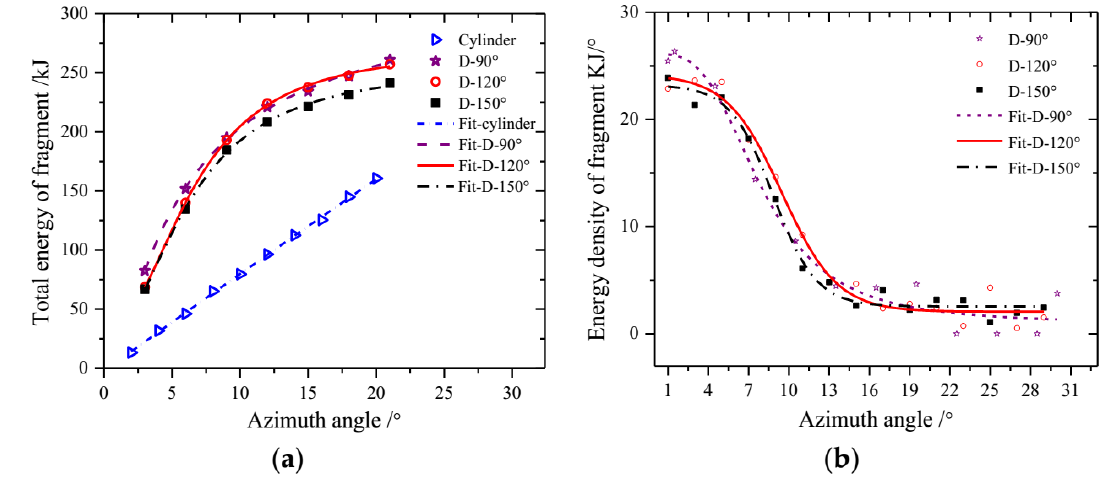
Figure 10. Relationships between the total energy of fragment, energy density of fragment and azimuth angle. ( a ) Total energy of fragment vs. azimuth angle; ( b ) energy density of fragment vs. azimuth